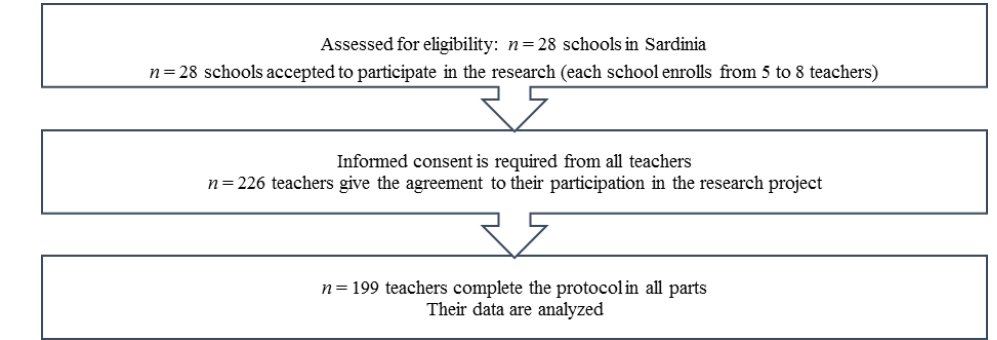
Figure 1. Recruiting phases.